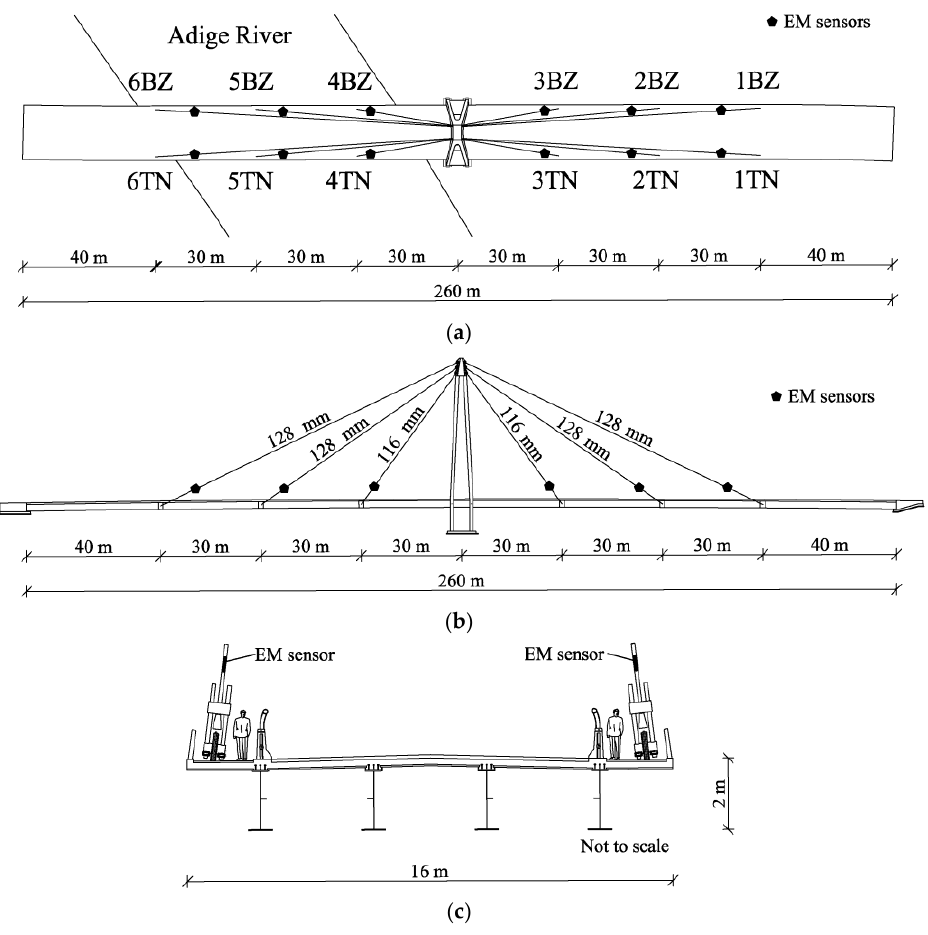
Figure 1. Adige Bridge: ( a ) plan view with sensor names (1TN–6TN, 1BZ–6BZ); ( b ) lateral view; ( c ) cross-section of the deck.